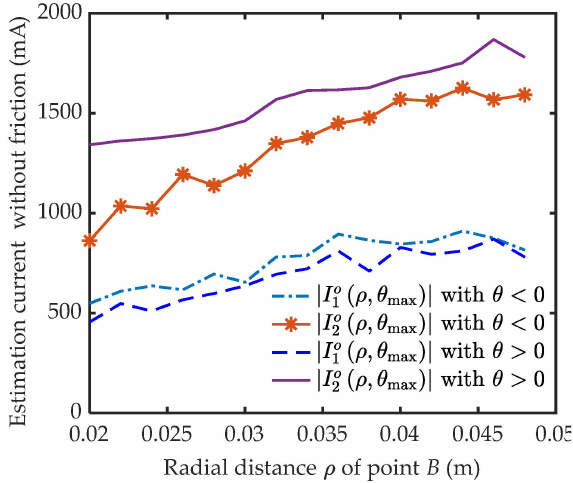
Figure 26. Current comparison with different deflection direction.